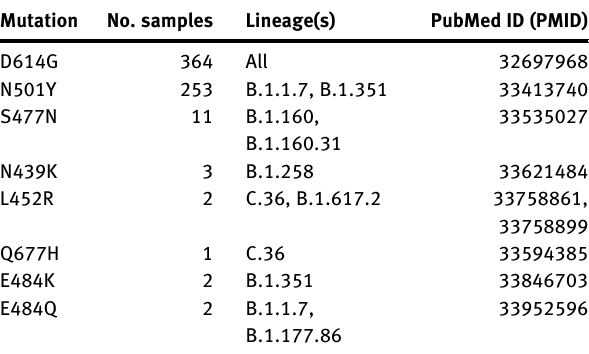
Table  : Known mutations of the spike protein reported to enhance infectivity or to enable immune escape found in the sequenced SARS-CoV-  genomes.